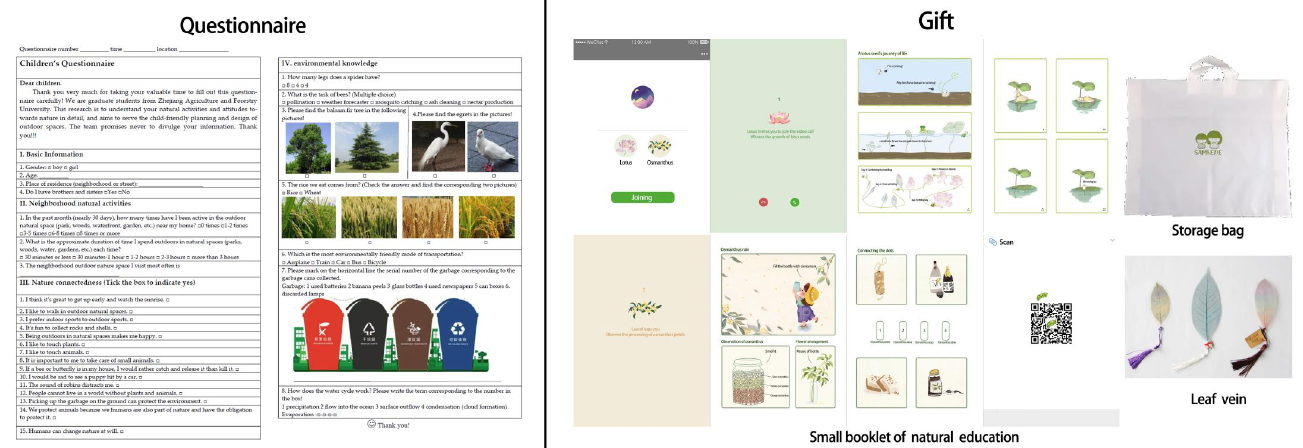
Figure 3. Questionnaire and